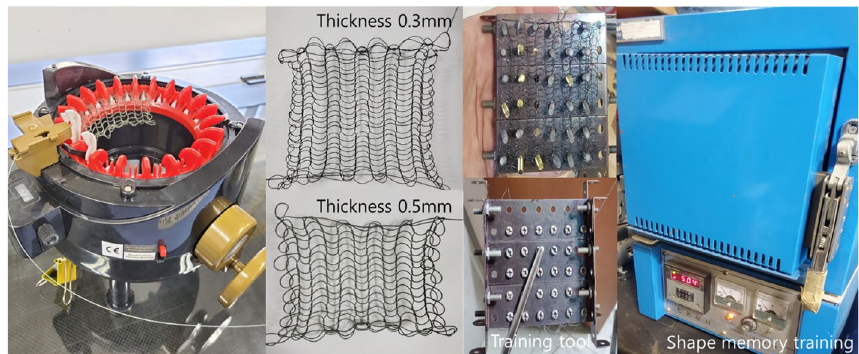
Fig. 3 Production and training process of shape memory textile